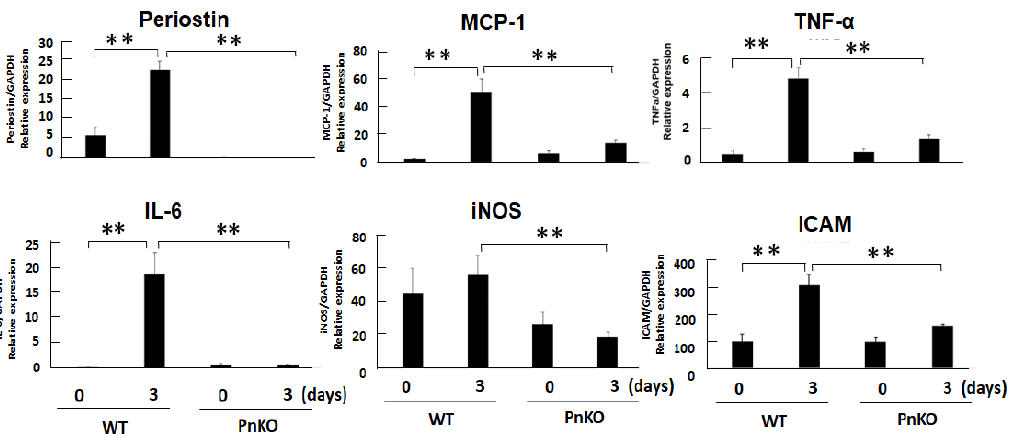
Figure 5. The expression of periostin and inflammation markers in the kidney of the rhabdomyolysis model. All markers of inflammation declined in the Pn-null rhabdomyolysis mouse model compared with the wildtype rhabdomyolysis mouse model. ** p < 0.01 vs. day 0 (WT) and day 3 (PnKO). n = 6.